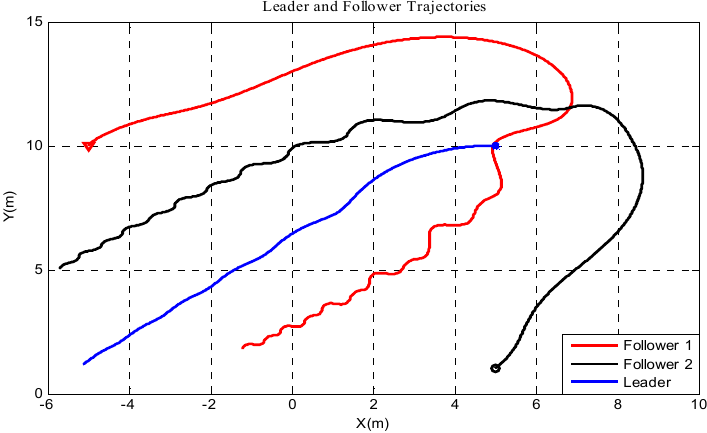
Figure 6. Leader-follower trajectories in Example 1.